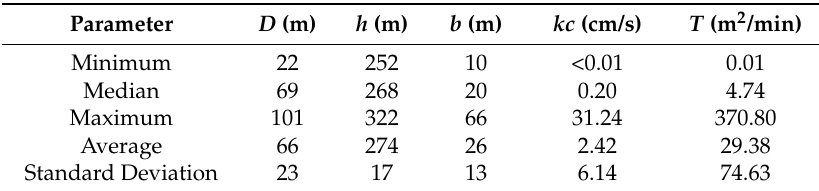
Table 2. Statistics of boreholes and aquifer characteristics obtained from pumping test data of 38 boreholes ( D is borehole’s depth, h is borehole’s elevation, b is saturated thickness of an aquifer, kc is aquifer hydraulic conductivity and T is aquifer